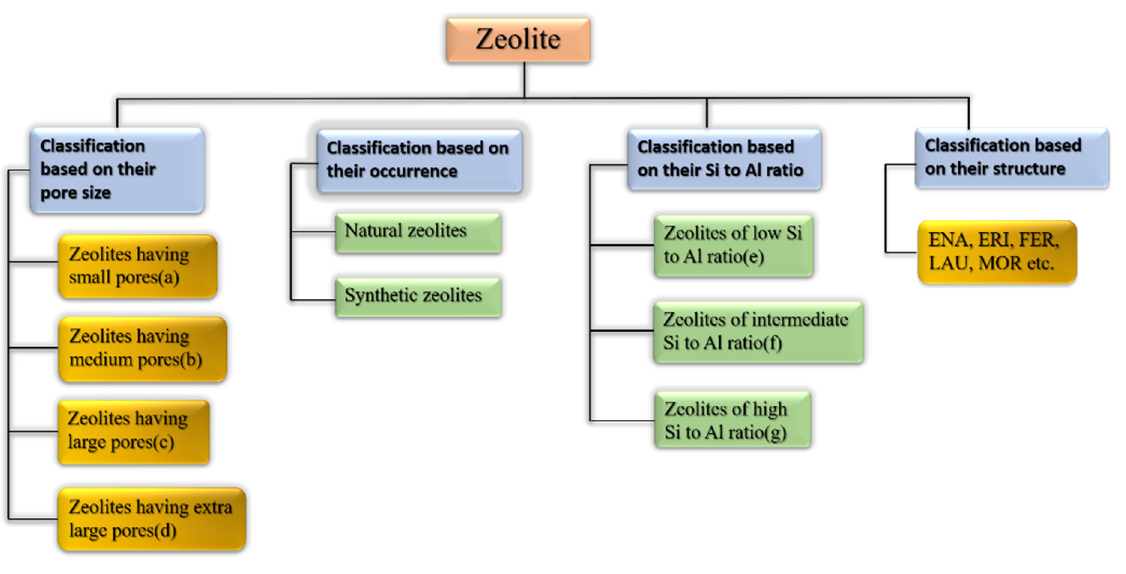
Figure 6. Broad classification of zeolites. Table 3. Classification of zeolites according to their pore size.